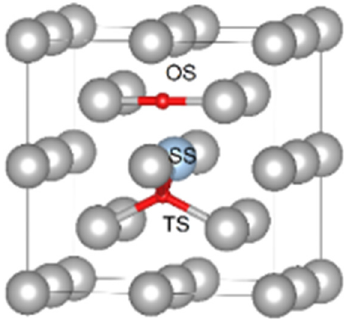
Figure 1. Possible sites for H in the bulk of bcc Fe. The red spheres correspond to the interstitial positions (OS, TS correspond to the octahedral and tetrahedral sites) and the blue sphere corresponds to the substitutional site (SS).